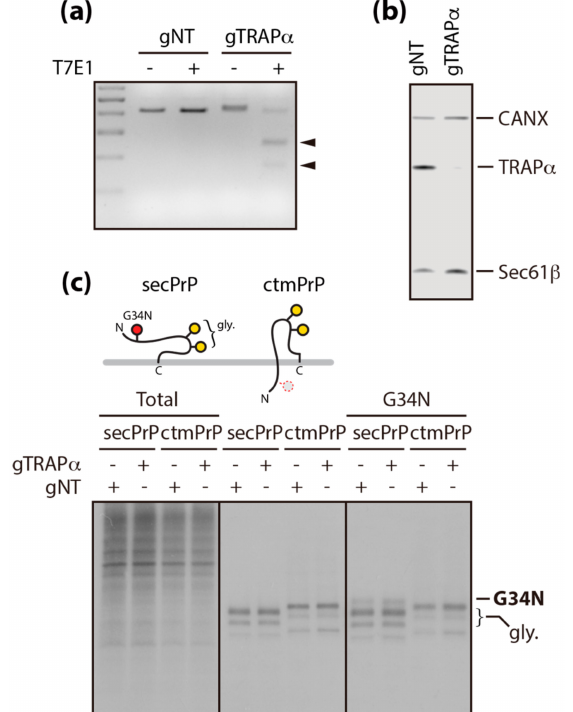
Figure 1. Analyses of newly synthesized PrP in TRAP α -deficient cells. ( a ) A TRAP α -deficient cell line (gTRAP α ) was created using CRISPR / Cas9 genome editing, using a TRAP α -targeting sgRNA. Gene editing was confirmed using T7E1 assay. Heteroduplex fragments cleaved by T7E1 are indicated as arrowheads. gNT: cell line expressing non-targeting gRNA as a negative control. ( b ) Specific elimination of TRAP α protein was verified in fully solubilized TRAP α -deficient cells by immunoblotting with calnexin (CANX)-, Sec61 β -, and TRAP α -specific antibodies. ( c ) Topological di ff erences between secPrP and ctmPrP are illustrated in the upper panel. Newly synthesized secPrP and ctmPrP in pulse-labeled gNT and gTRAP α cells transiently transfected with wtPrP (secPrP) or N7a-PrP-AV3 (ctmPrP) constructs were analyzed by immunoprecipitation with the PrP-specific 3F4 antibody (lower middle panel). In this manner, the luminal localization of the N-terminal region was determined in these cell lines expressing mutant PrPs carrying the G34N mutation (lower right panel). Equal loading and translation were verified by determining total newly synthesized protein content in the cells (lower left